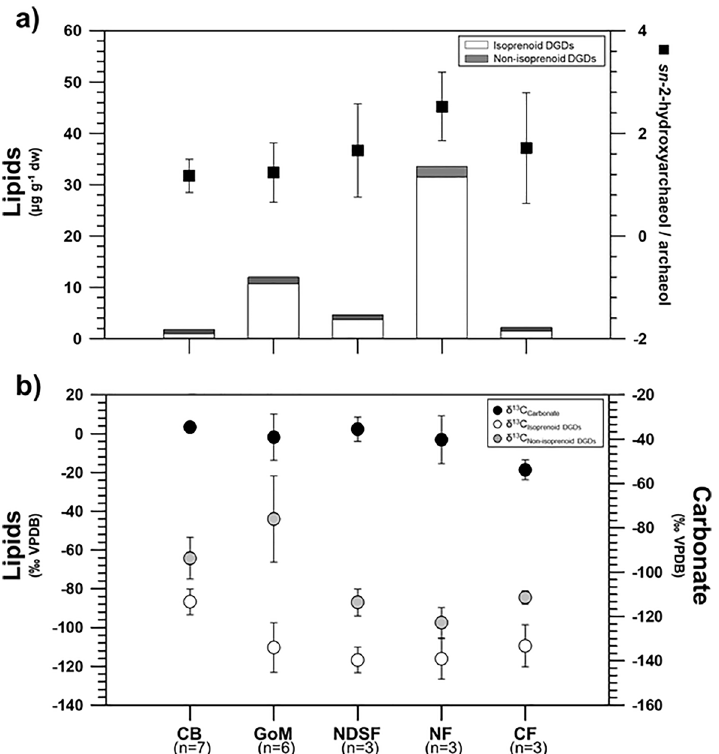
Figure 6. Comparison of lipid biomarker signatures of authigenic carbonates from the CB, Congo fan (CF), Nile deep-sea fan (NDSF), Niger fan (NF), and Gulf of Mexico (GoM): ( a ) concentrations of major lipid biomarkers and ratios of sn -2-hydroxyarchaeol relative to archaeol, and ( b ) carbon isotopic compositions of major lipid biomarkers with those of